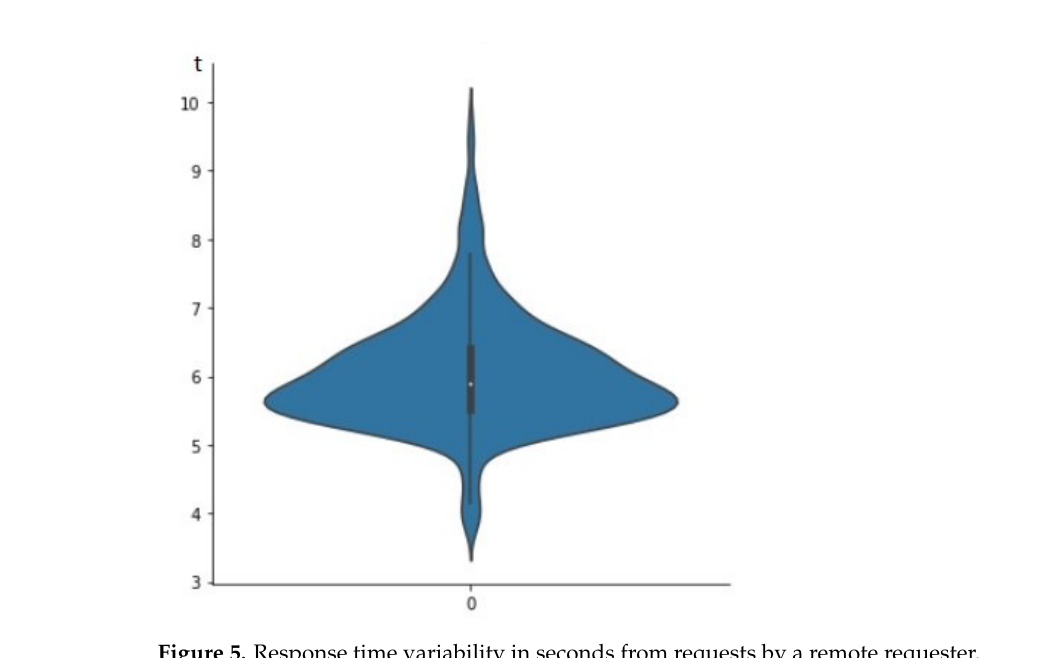
Figure 5. Response time variability in seconds from requests by a remote requester.